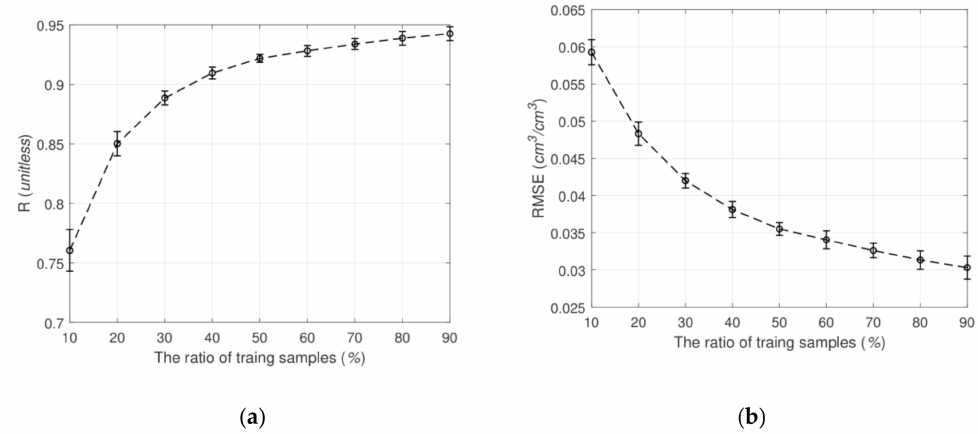
Figure 9. Effects of the ratio of training samples (%) on the SM retrieval performance. ( a ) R and ( b )